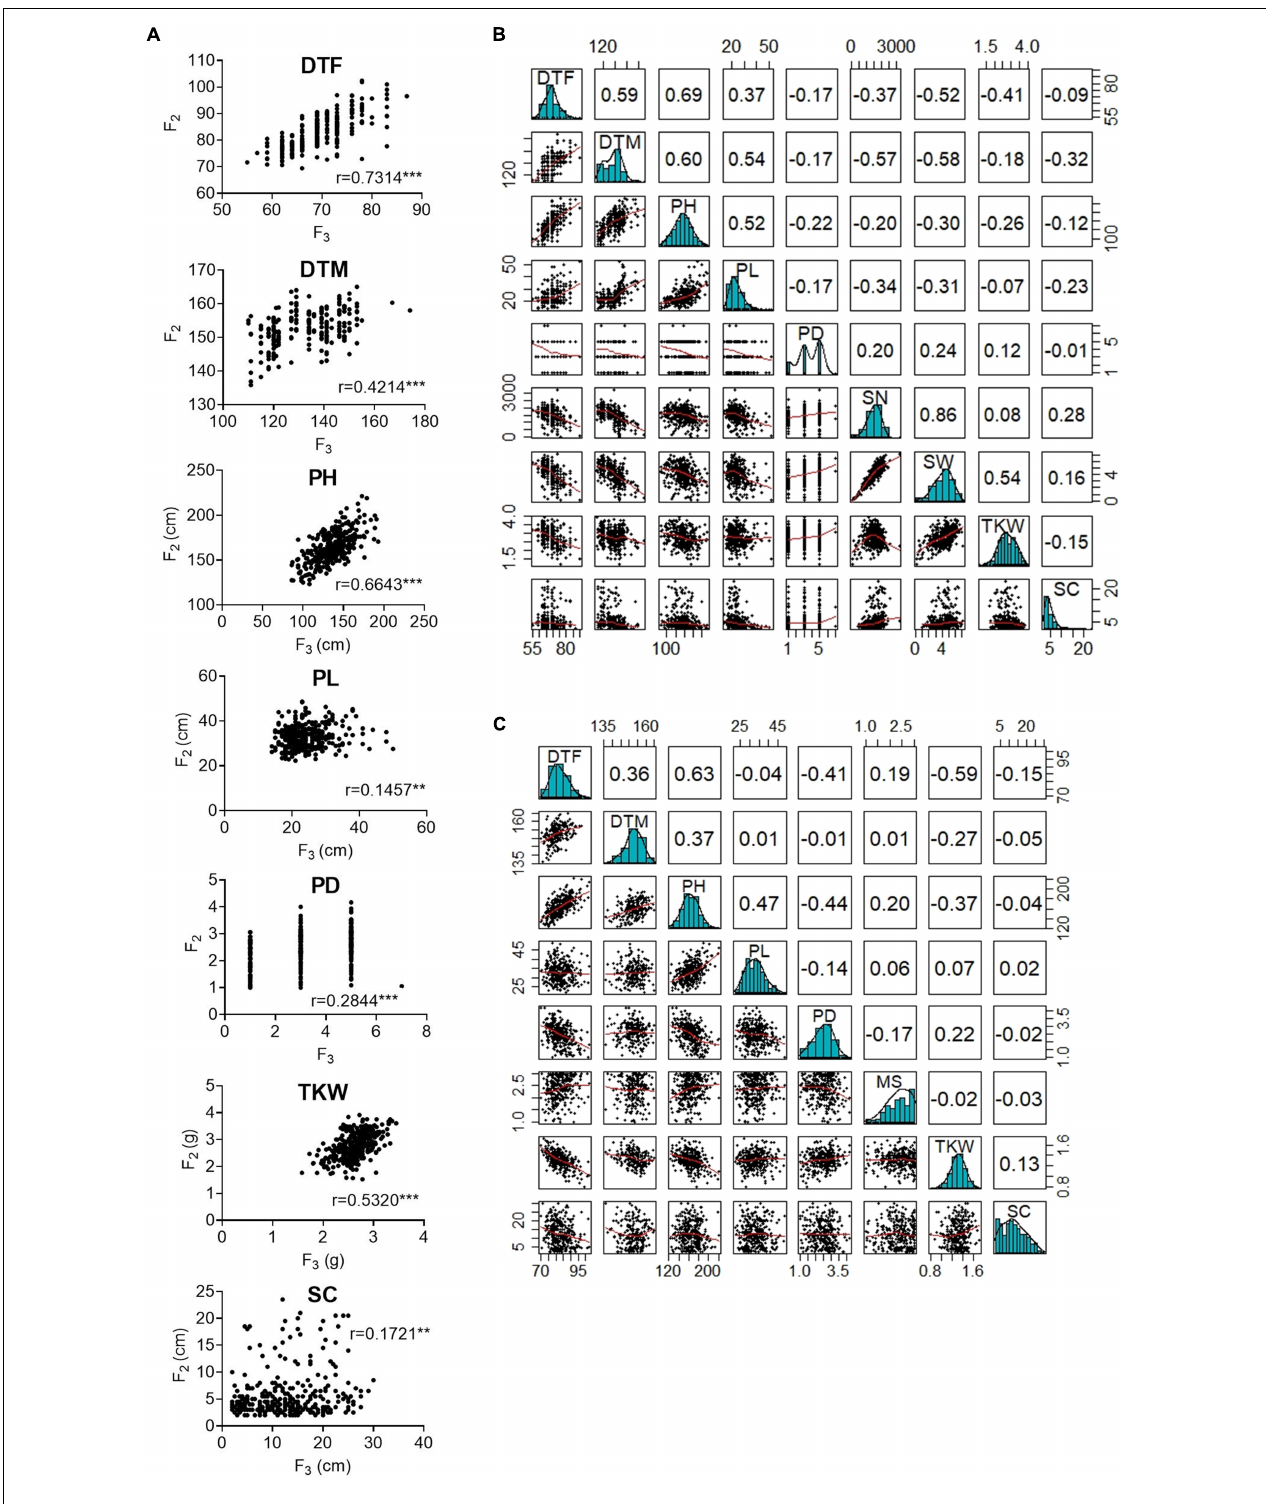
FIGURE 1 | Correlation between phenotypic traits measured in the F 2 and F 3 populations. (A) Pearson’s r correlations between F 2 and F 3 populations. (B) Correlations between nine traits measured in the F 2 population (C) Correlations between eight traits measured in the F 3 population. In panels (B,C) , bivariate scatter plots are shown below the diagonal, histograms on the diagonal, and the Pearson correlation above the diagonal. DTF, days to flowering; DTM, days to maturity; PH, plant height; PL, panicle length; PD, panicle density; TKW, thousand kernel weight; SW, seed weight per plant; SN, seed number per plant; MS, Mildew susceptibility; SC, saponin content. Correlations significance at α < 0.05 = ***, α < 0.01 = **, α < 0.001 = * levels.